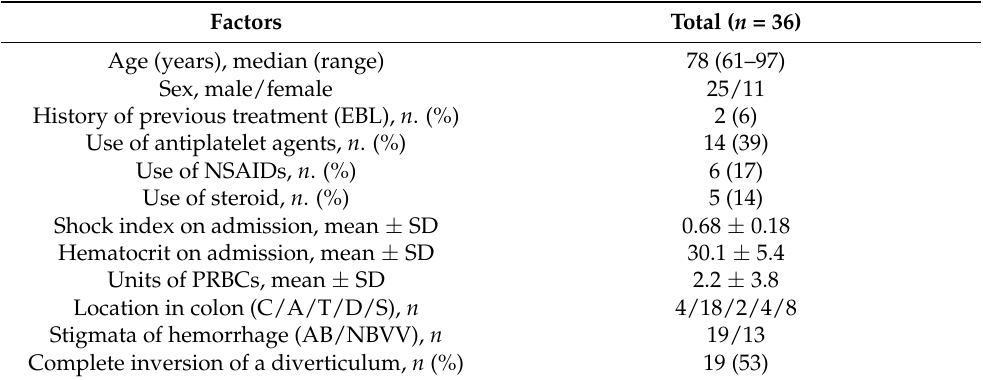
Table 1. Characteristics of patients treated by the OTSC method for colonic diverticular bleeding.